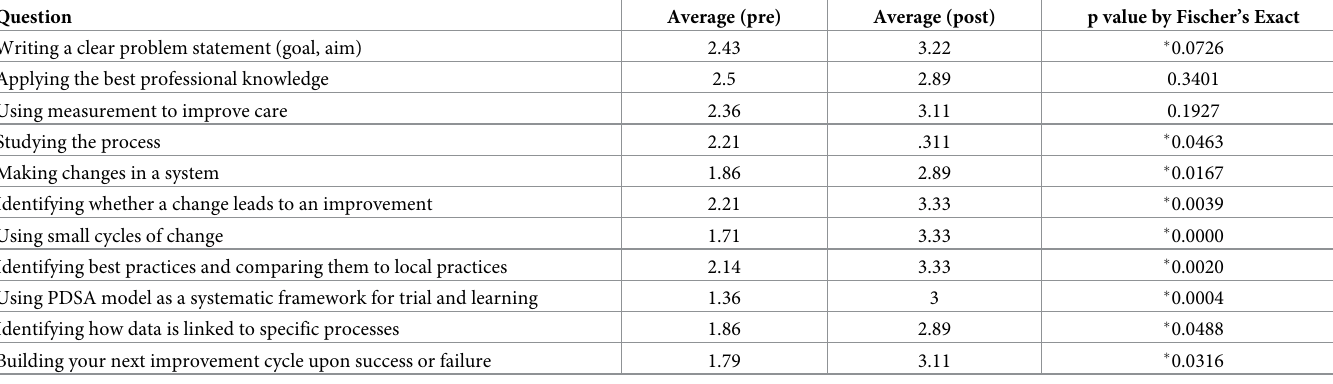
Table 1. Difference in self-reported acquisition of skills pre and post QI course.